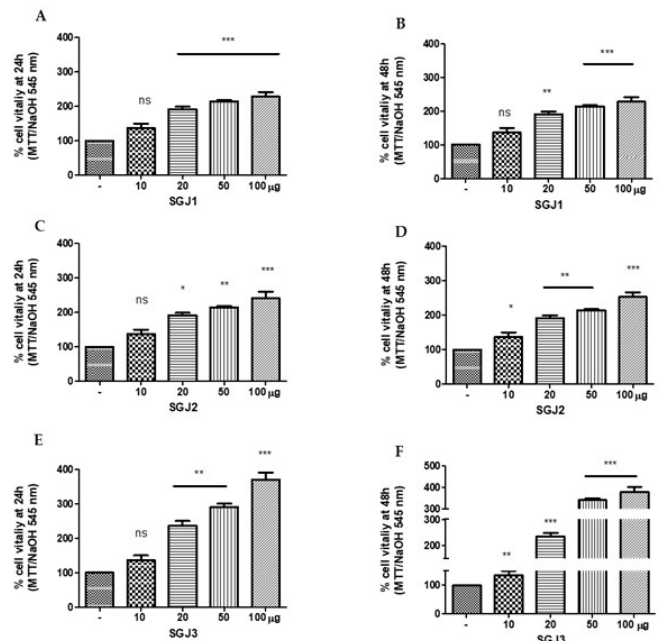
Figure 7. MTT assay of HaCat cells line treated with crude glucans ( A ) from SGJ1 (soluble glucans from jujubes of first harvesting); ( C ) SGJ2 (soluble glucans from jujubes of second harvesting); ( E ) SGJ3 (soluble glucans from jujubes of third harvesting) after 24 h and ( B ) SGJ1, ( D ) SGJ2, and ( F ) SGJ3 after 48 h. * P < 0.05, ** P < 0.01 and *** P < 0.001 in comparison with control.